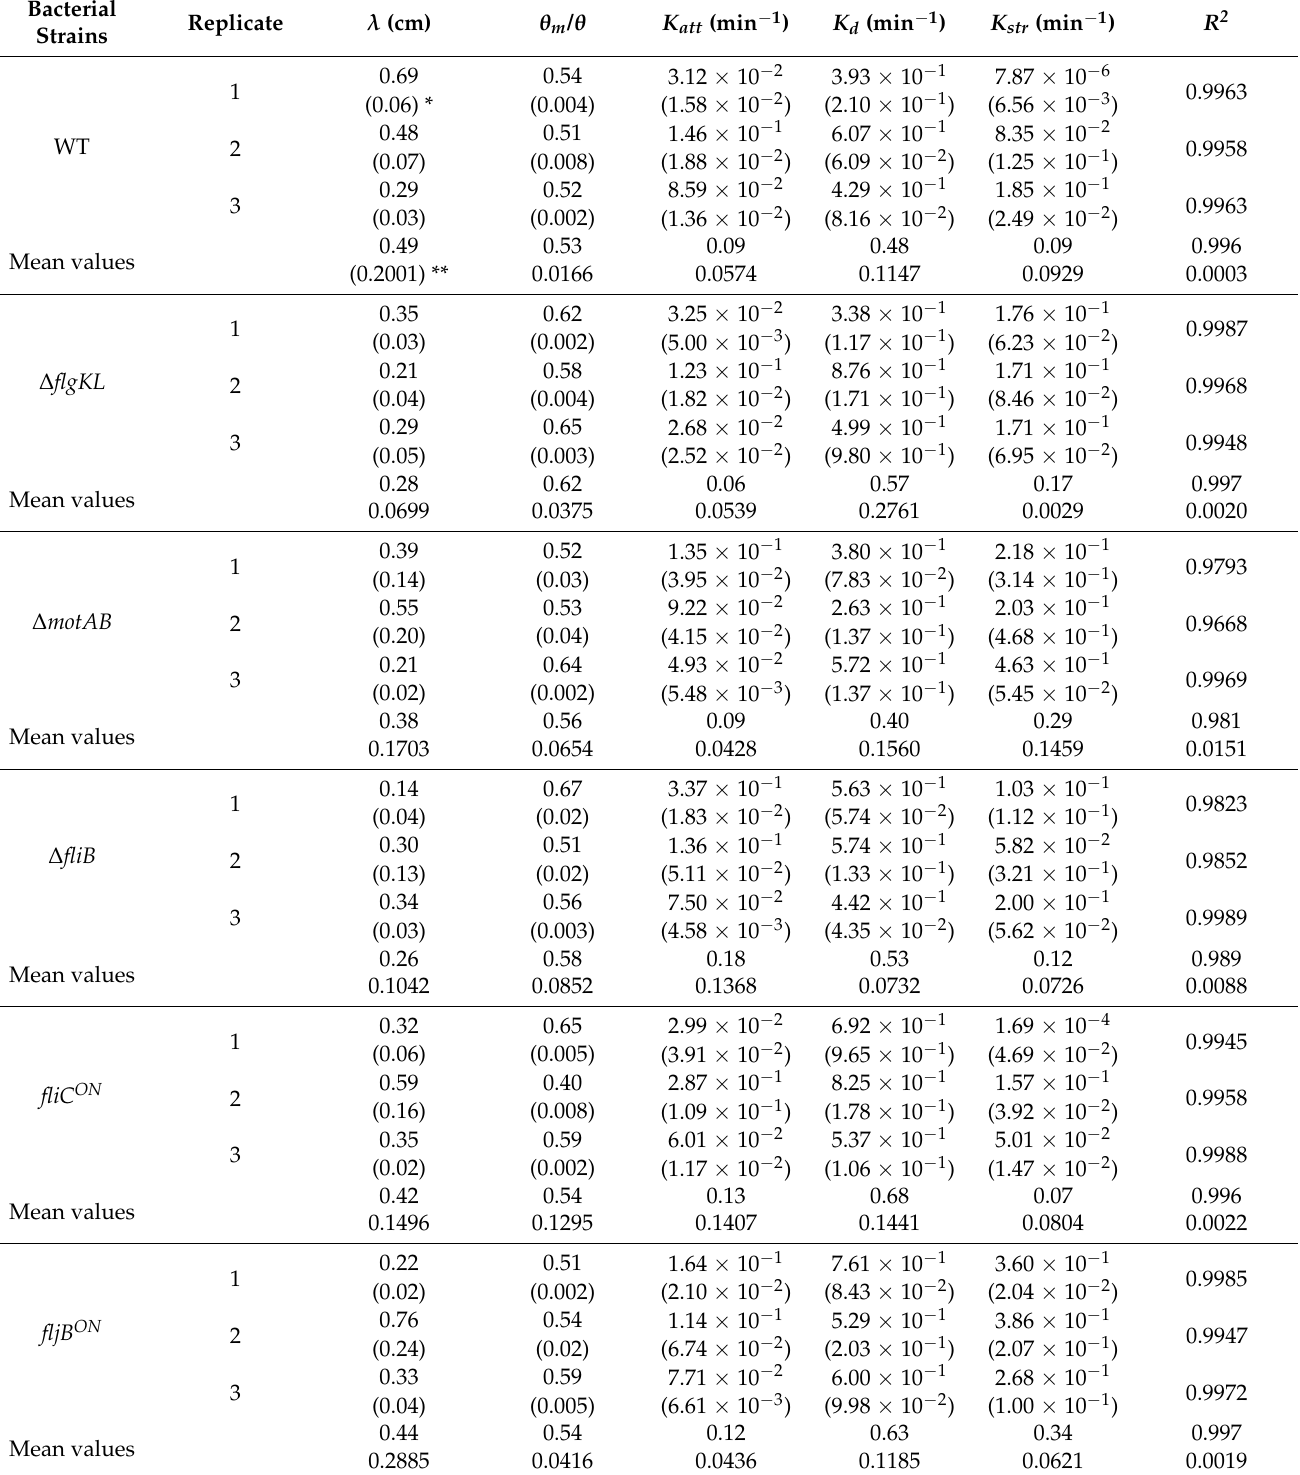
Table 3. Fitted parameters (replicates) for S. Typhimurium through saturated columns using the MIM model in HYDRUS-1D